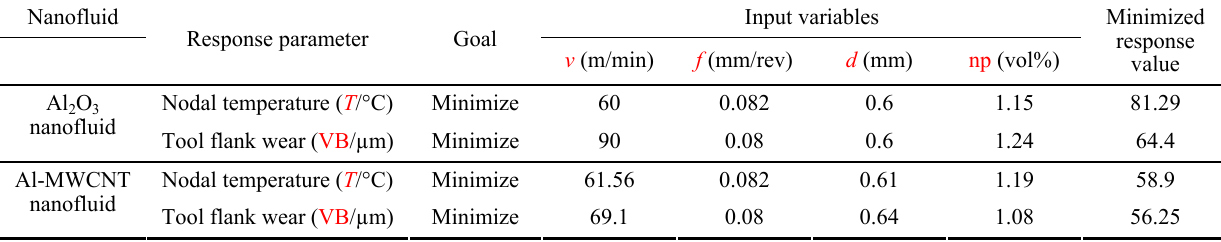
Table 7 Minimized response parameters for Alumina and Al-MWCNT nanofluid.